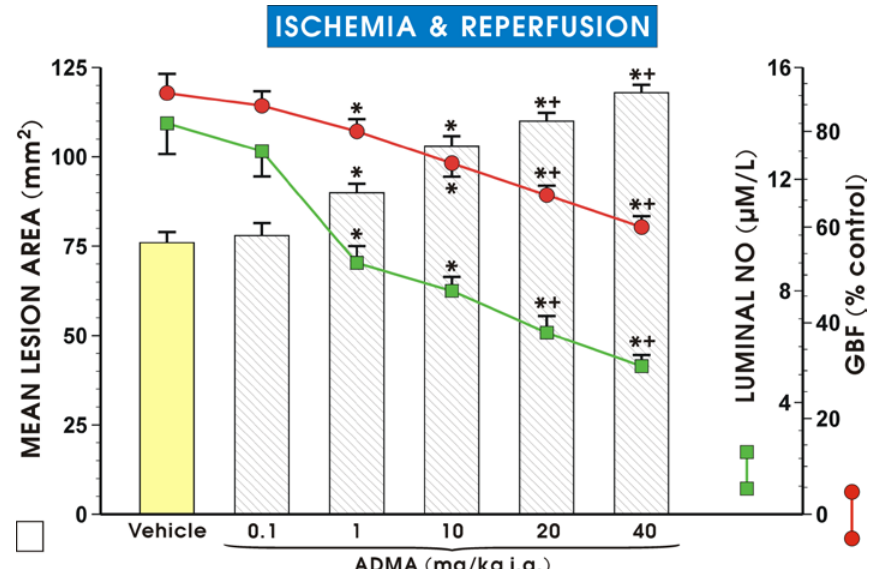
Figure 1. Mean lesion area, gastric blood flow (GBF) level, and gastric luminal NO concentration after application of vehicle (saline) or ADMA administered in graded doses (0.1–40 mg/kg i.g.) followed by exposure to ischemia/reperfusion. Results are mean ± S.E.M. of seven rats per group. Significant change ( p < 0.05) as compared with the respective values in vehicle-control group is indicated by an asterisk. A cross and asterisk indicate significant change ( p < 0.05) when compared to the values obtained in vehicle-controls and in those pretreated with ADMA (1 or 10 mg/kg